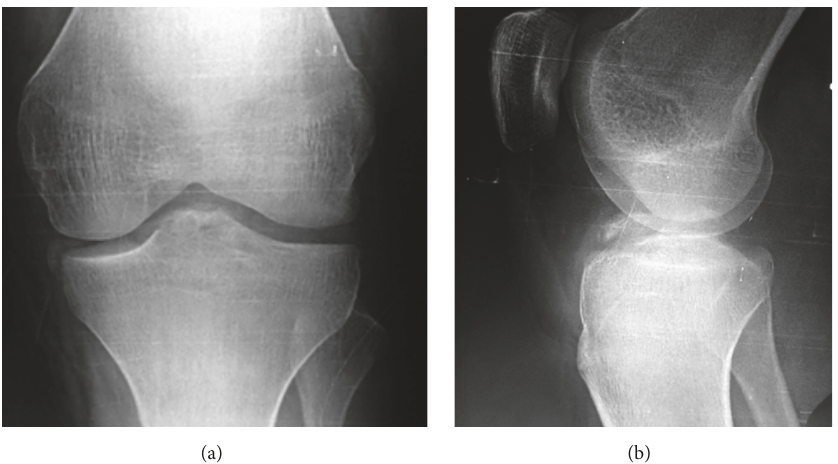
Figure 1: Anteroposterior (a) and lateral (b) preoperative radiographs showing tibial eminence and reverse Segond fractures.